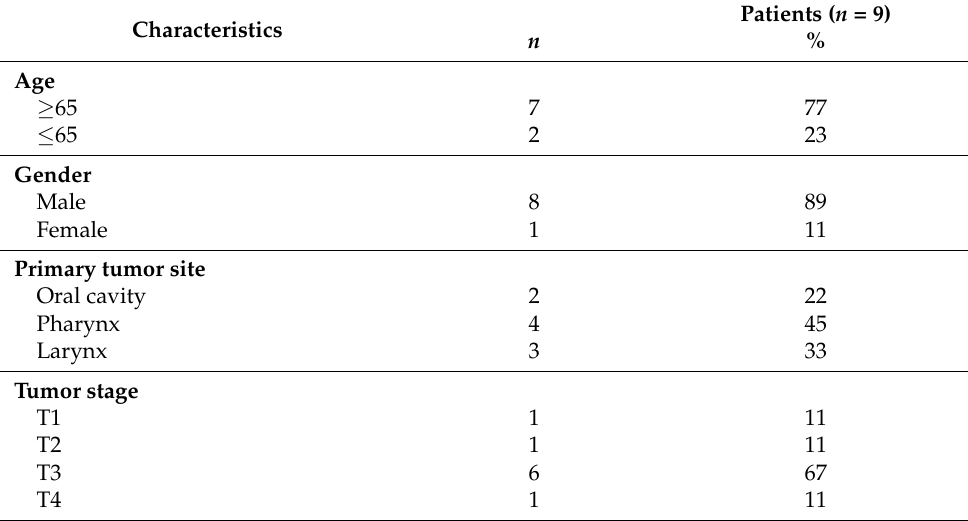
Table 1. Patient